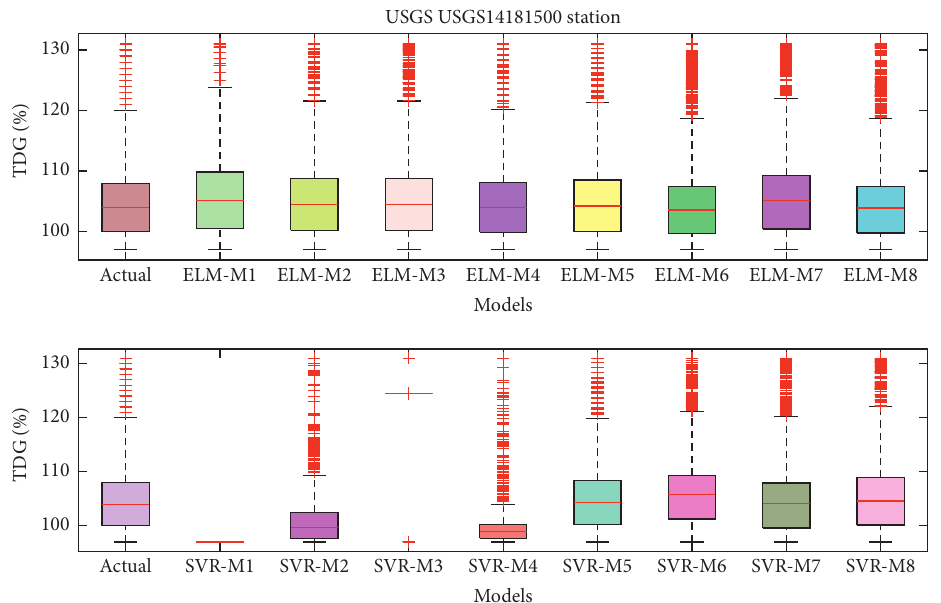
Figure 6: Boxplot presentation for USGS 14181500 station: (a) ELM and (b) SVR